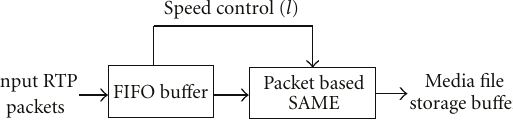
Figure 4: RTP data encryption in RPS system.